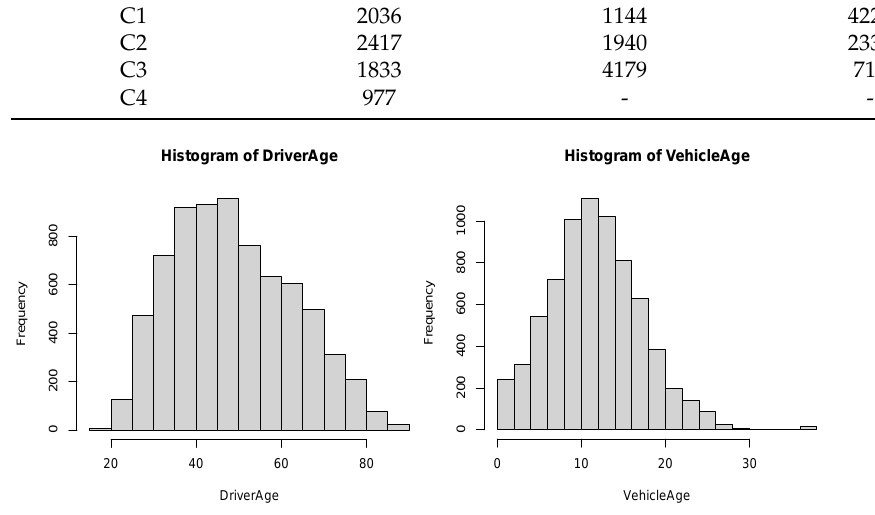
Figure 2. Empirical distributions of continuous explanatory variables. Table 3. Estimated parameters and standard errors in parentheses for the BPA and BEIG regressions model. AIC: Akaike information criterion; BIC: Bayesian information criterion.